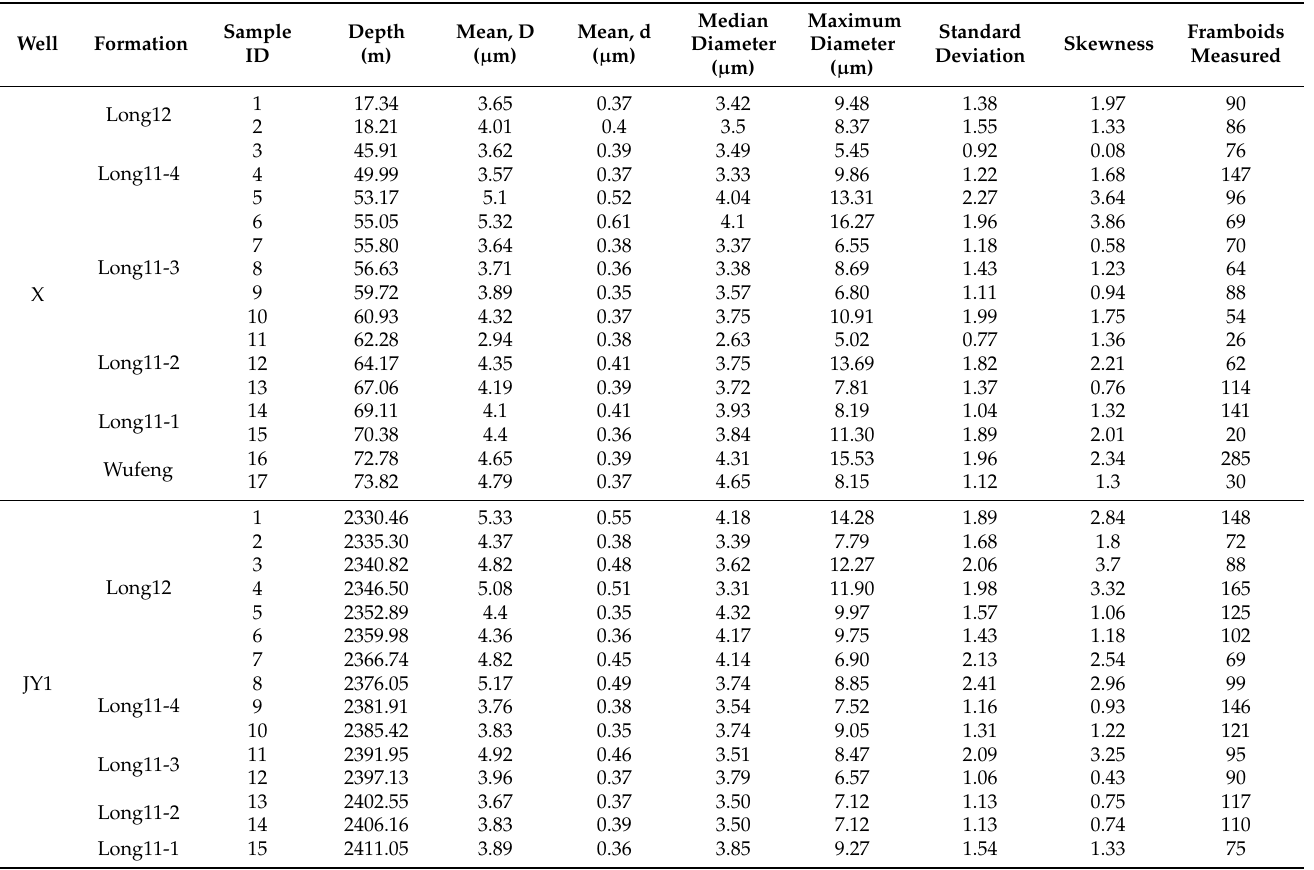
Table 1. Descriptive statistics of pyrite framboid size distribution from the Wufeng and Longmaxi shales in the southeast Sichuan